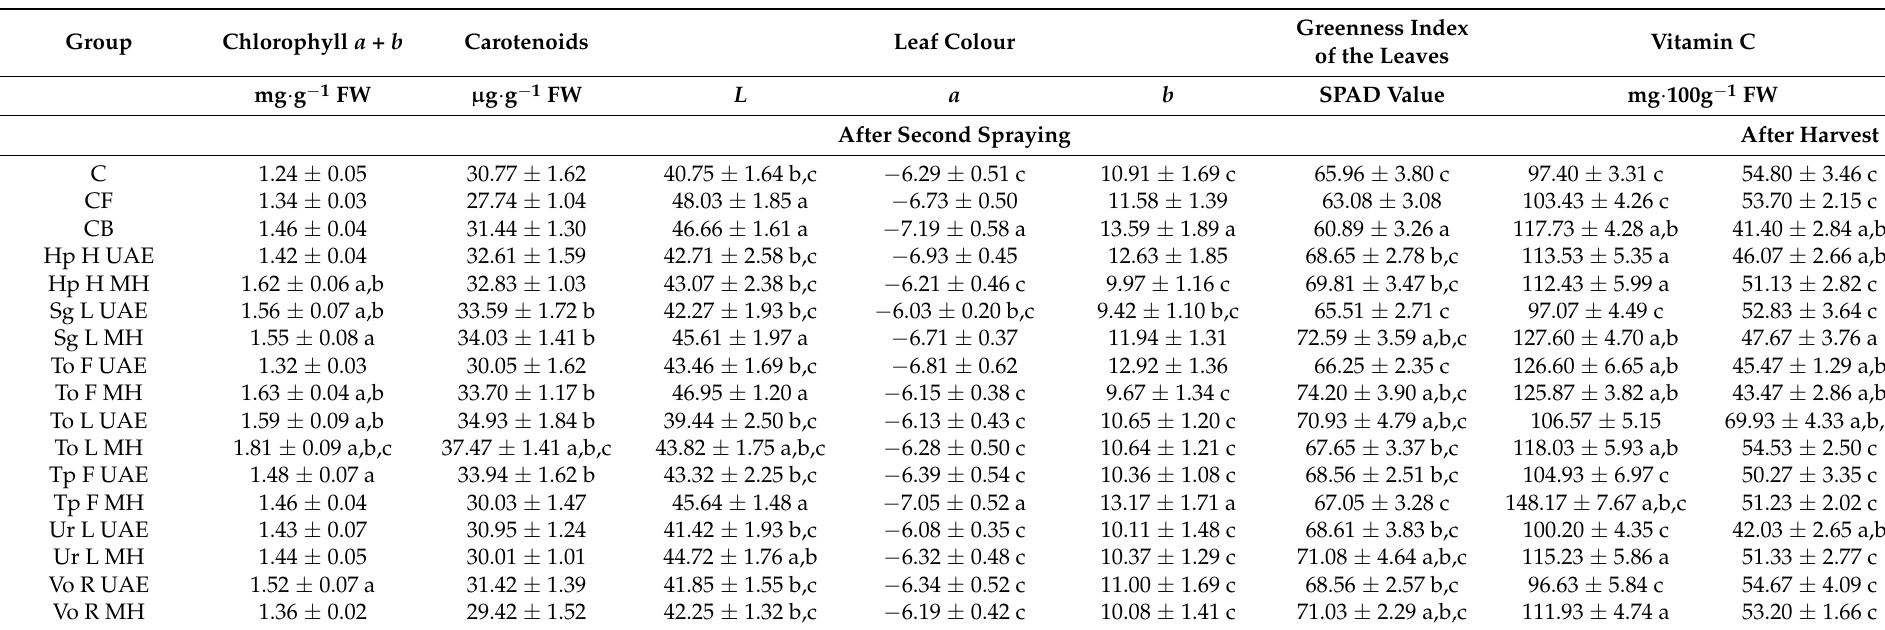
Table 2. Effect of the foliar application of the botanical extracts on the chlorophyll a + b and carotenoids content in leaves after second spraying ( n = 4, mean ± SD), the L , a , b and SPAD values of leaves after second spraying ( n = 16, mean ± SD), and vitamin C content in leaves after second spraying and cabbage head after harvest ( n = 4, mean ±